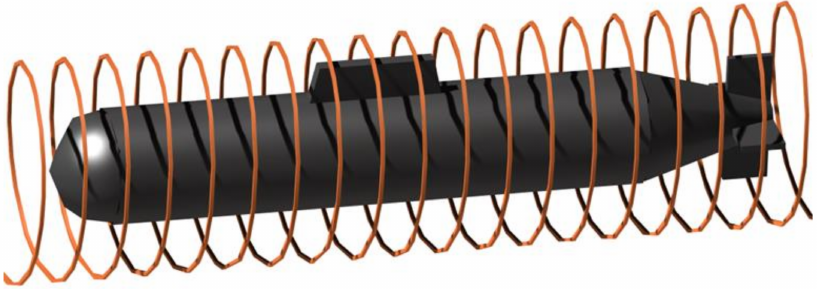
Figure 1. Demagnetization of a